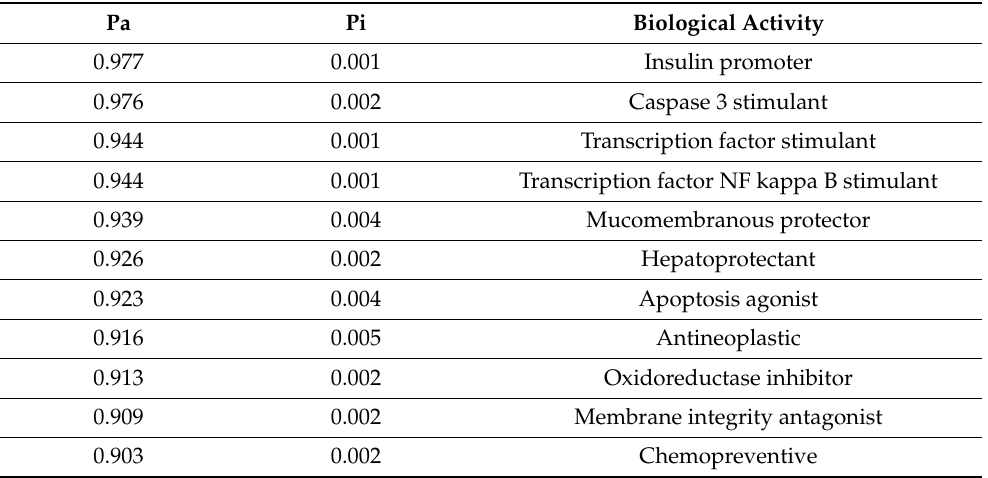
Table 7. Calculated pharmacological profile of β -Amyrin (natural